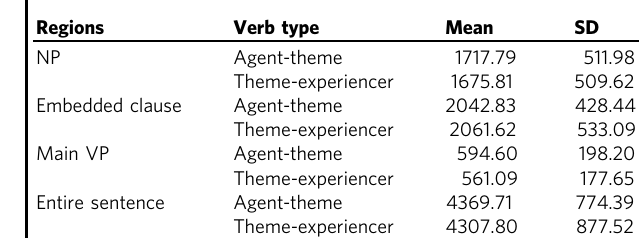
Table 6 RTs and SD for SRC with an inanimate head containing two verb